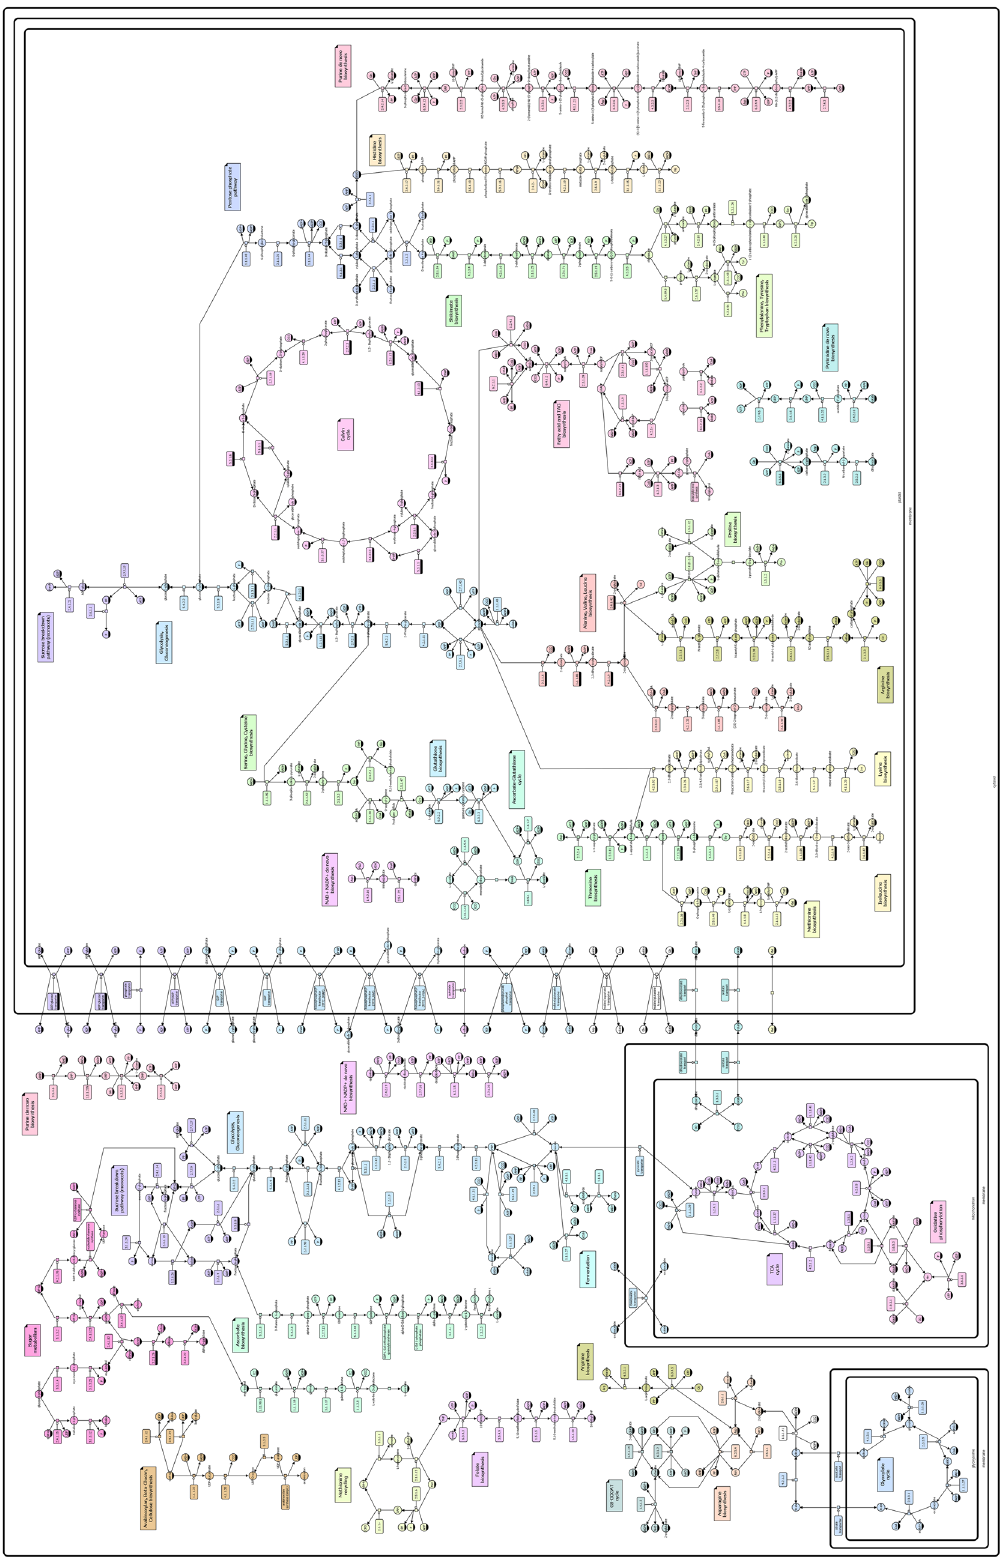
Figure 3: A SBGN map representing major parts of the central metabolism in monocotyledon plants (from